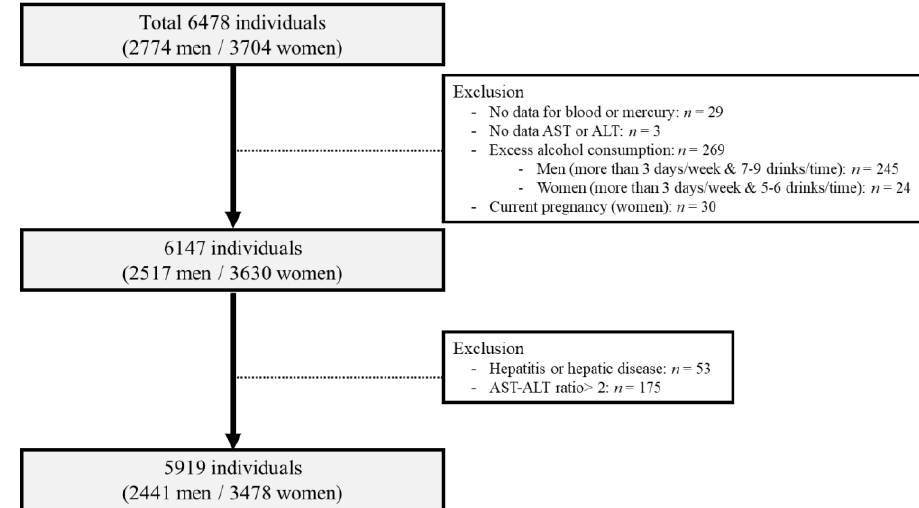
Figure 1. Flow diagram of study participants in the study obtained from the Korean National Environmental Health Sur- vey II (2012 – 2014). Environmental Health Survey II